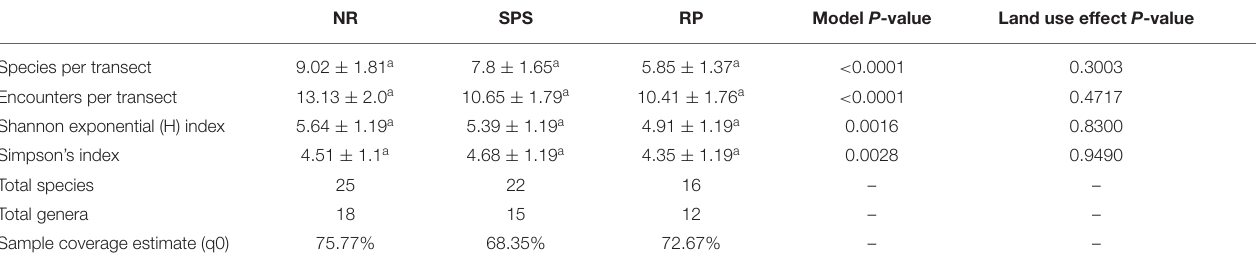
TABLE 4 | Means and standard error for number of species and encounters per transect, Shannon and Simpson indices, as well as total number of species and genus, sample coverage from estimated species richness for Natural Regeneration (RN), silvopastoral systems (SPS), and rubber plantations (RP) in Colombian Amazon region.